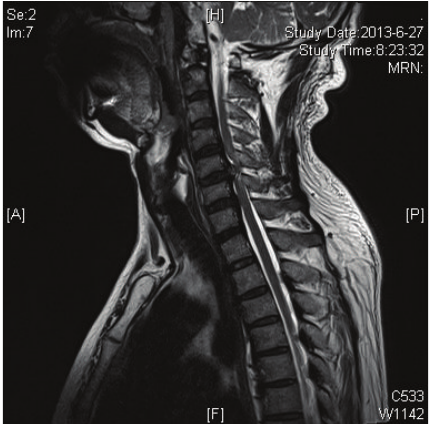
Figure 2: T2-weighted sagittal magnetic resonance image. A C5-6 herniated disc is seen indenting the cord. The mass is surrounded by CSF signal intensity margin, and caudally the ventral dura line appears divided into two, the so-called “Y-sign.”